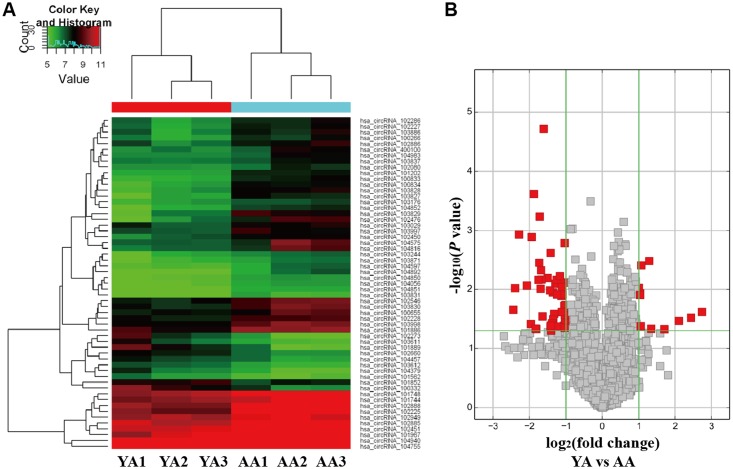
CircRNA expression profiles in GCs according to maternal age.(A) Hierarchical clustering analysis of differentially expressed circRNAs in GCs of three young (≤ 30 years) and three older (≥ 38 years) women. Expression values (fold change > 2.0, P < 0.05) were represented in different colors, indicating expression levels above and below the median expression level across all samples. (B) Volcano plot was constructed using fold-change and P-values. The vertical lines correspond to 2.0-fold up- and down-regulation between YA and AA samples, and the horizontal line represents a P-value. Red dots represent the differentially expressed circRNAs with statistical significance (fold change > 2.0 and P < 0.05). Red dots on the left represent up-regulated circRNAs in older women, while those on the right represent down-regulated circRNAs in older women. YA, women with young age (≤ 30 years); AA, women with advanced age (≥ 38 years).